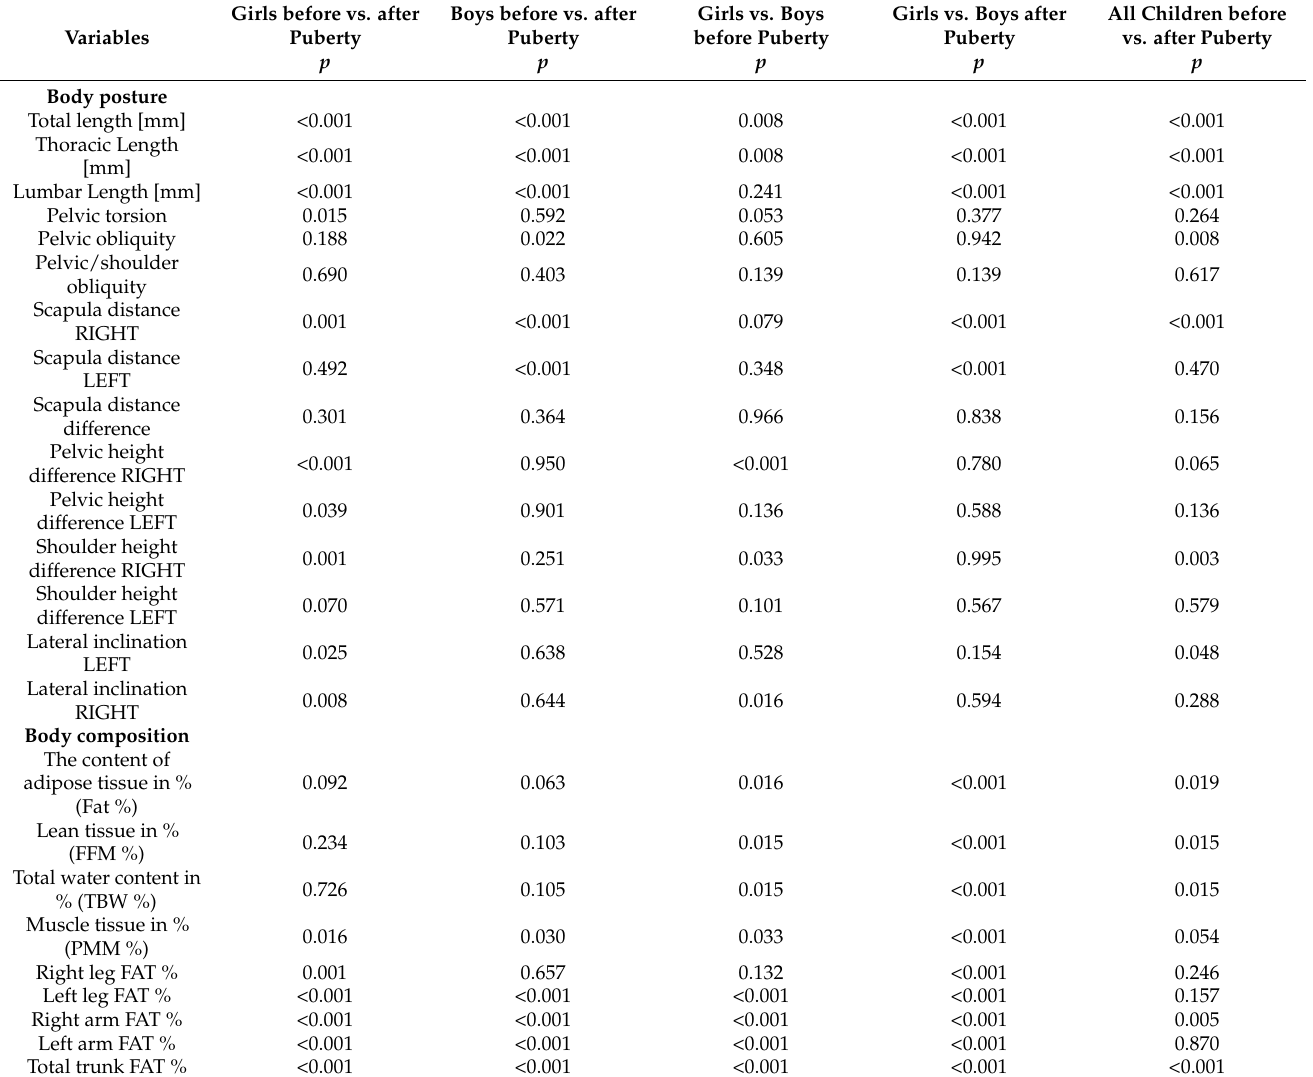
Table 5. The age of puberty and the parameters of posture and body weight in